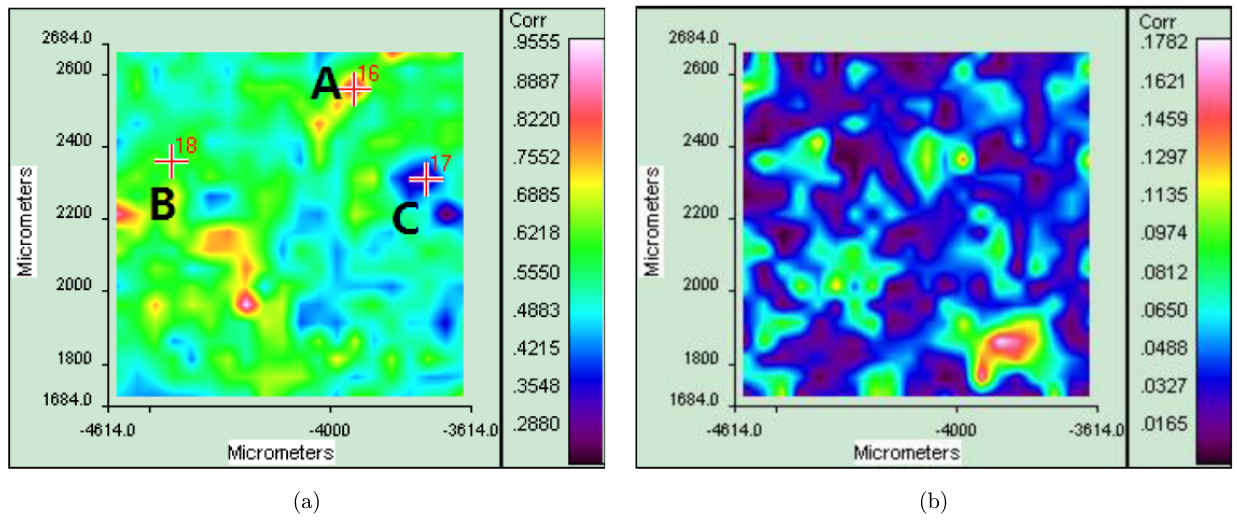
Fig. 3. Diclofenac sodium near-infrared spectral images correlation coe±cient of sample No. 6 (a) and sample No. 14 (b), with correlation coe±cient A ¼ 0 : 952, B ¼ 0 : 576, C ¼ 0 : 319.